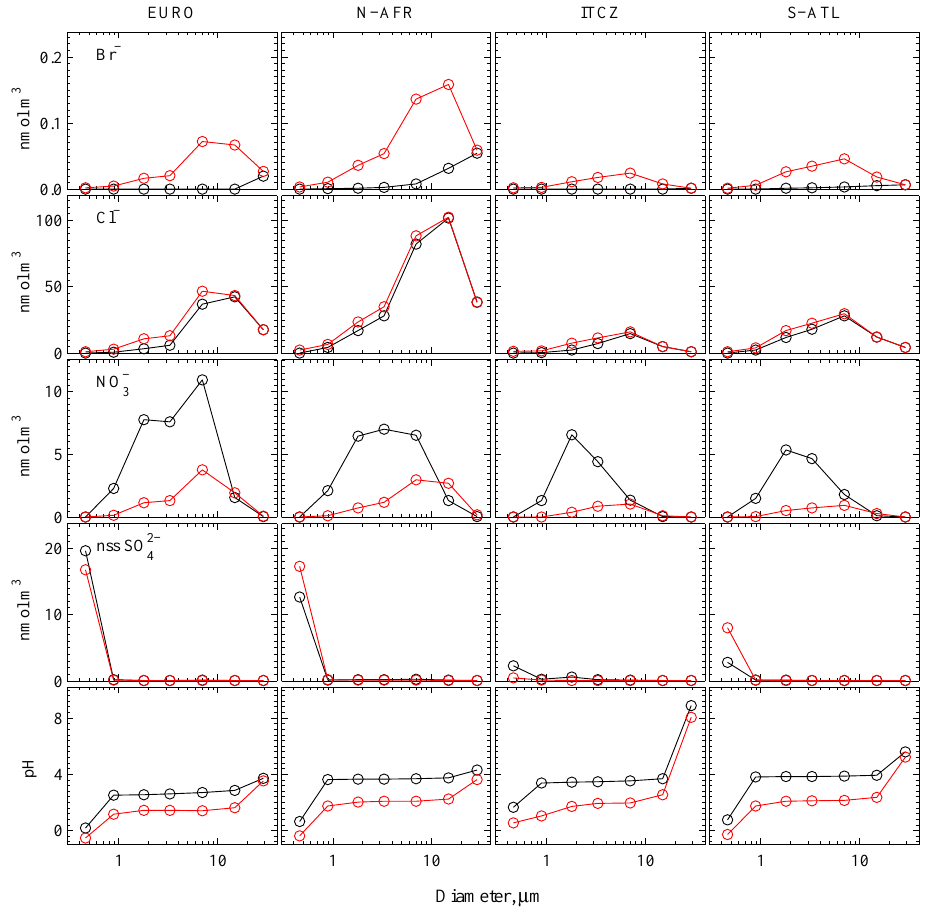
Fig. 9. Simulated average size distributions of particulate-phase species for the four flow regimes; values for runs “with halogens” are in Figure 9. black and those with “no halogens” are in red. To facilitate direct comparison with measured size distributions, constituents associated with the S size bin have been added to those associated with the smallest sea-salt size